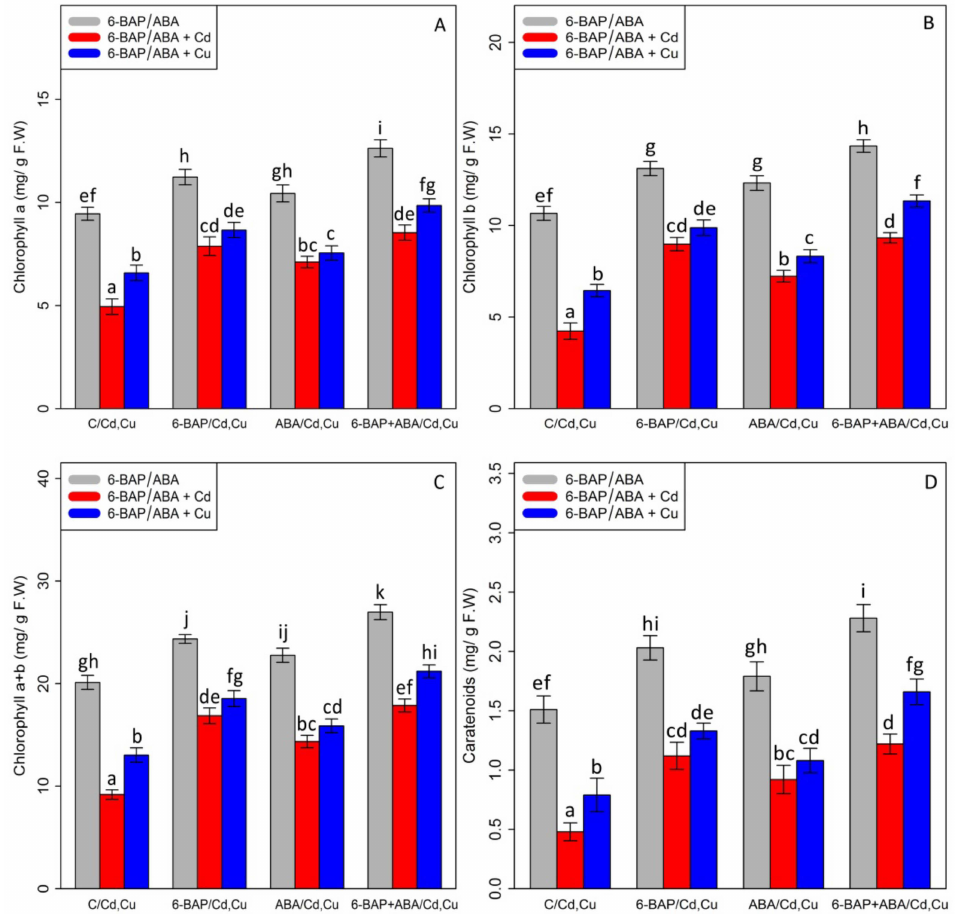
Figure 2. The impact of 6-benzylaminopurine and abscisic acid, alone and in combination, on chlorophyll a ( A ), chlorophyll b ( B ), total chlorophyll content ( C ), and carotenoids ( D ) in the one- year-old Pleioblastus pygmaeus exposed to 100 µ M Cd and 100 µ M Cu. In this figure, a, b, c. etc. letters revealed significant differences between 6-BAP, ABA and 6-BAP + ABA in single and in the combined form with 100 µ M cadmium and 100 µ M copper according to Tukey’s test ( p <